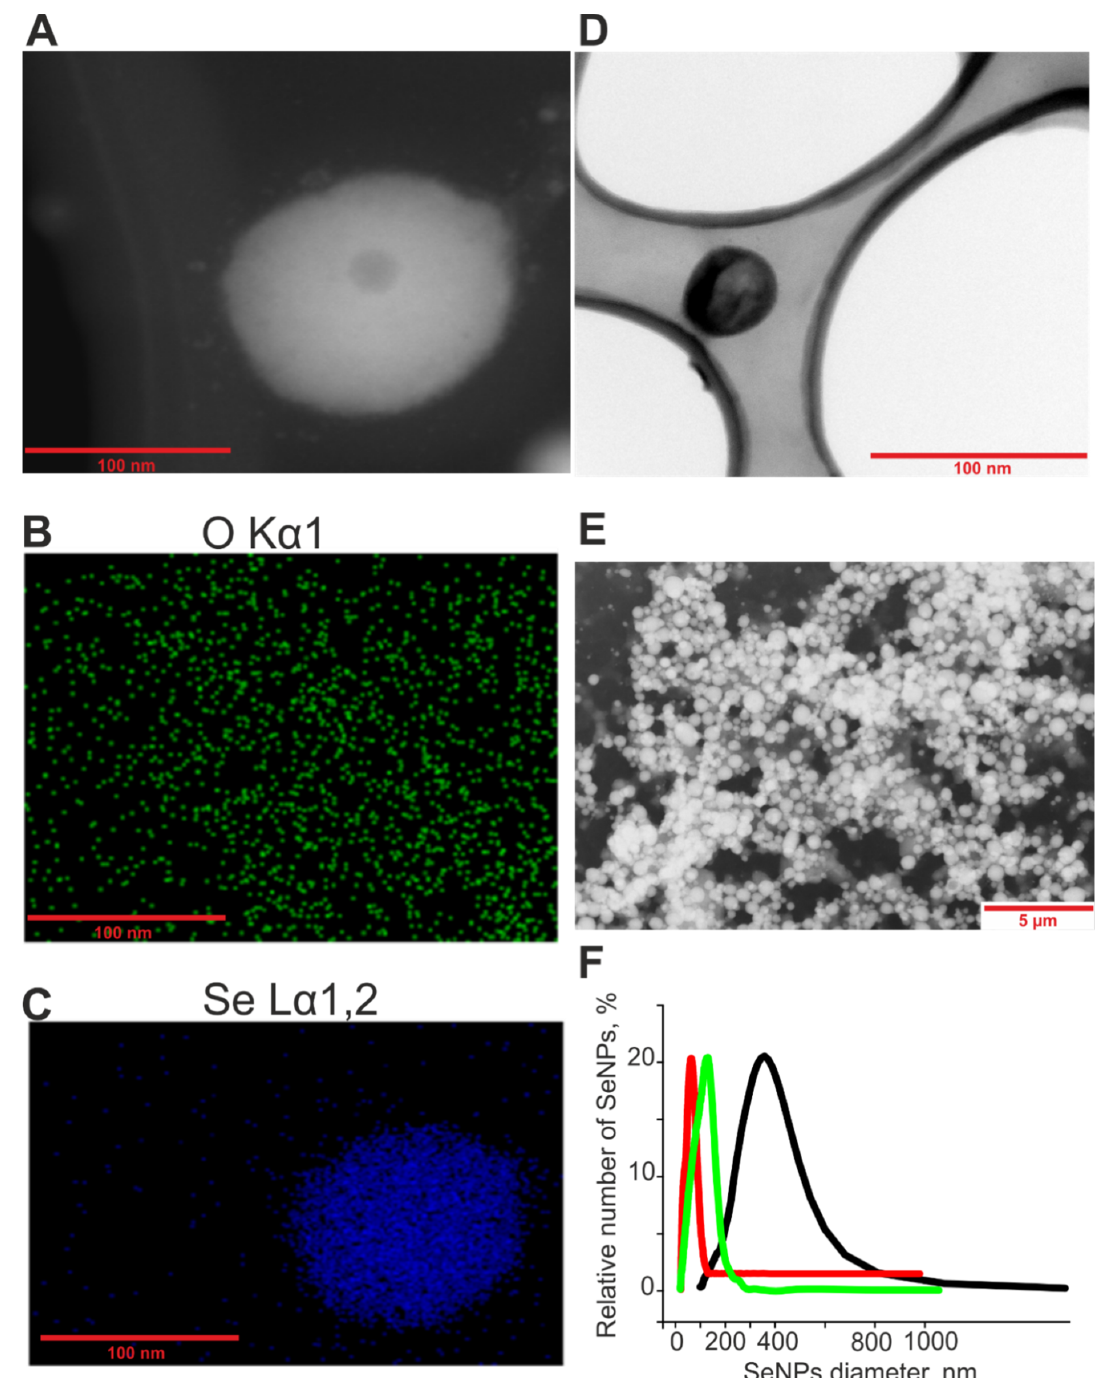
Figure 12. Shape, chemical composition, and size distribution of SeNPs. ( A )—TEM image of an individual nanoparticle with a diameter of about 100 nm (dark field image). ( B )—The distribution of oxygen atoms in panel ( A ). ( C )—The distribution of selenium atoms in panels A. ( D )—TEM image of an individual nanoparticle with a diameter of 50 nm (bright field image). ( E )—TEM image of a preparation of nanoparticles with an average diameter of about 400 nm (dark field image). ( F )—Size distribution of selenium nanoparticles – 50 nm-sized (red line), 100 nm-sized (green line) and 400 nm-sized (black line). Data obtained using an analytical disk centrifuge and confirmed by DLS. PDI 50nm = 0.25 ± 0.3; PDI 100nm = 0.29 ± 0.5; PDI 400nm = 0.34 ± 0.8 ( n = 3).